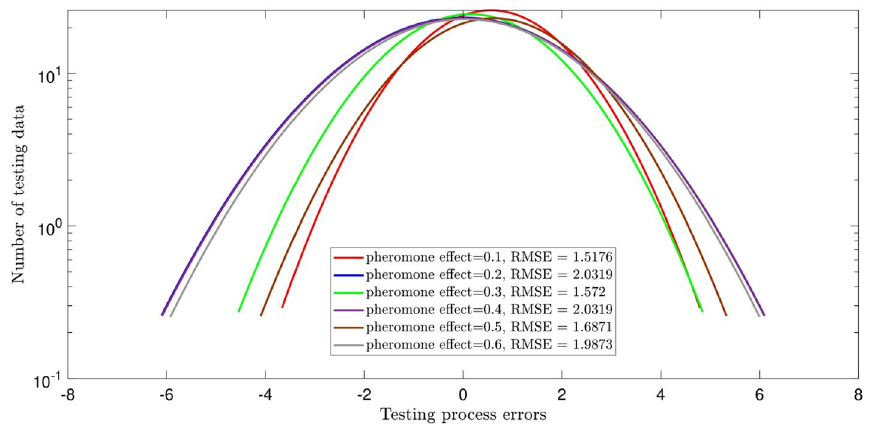
Figure 3. ACOFIS learning processes using three inputs and diversity of pheromone